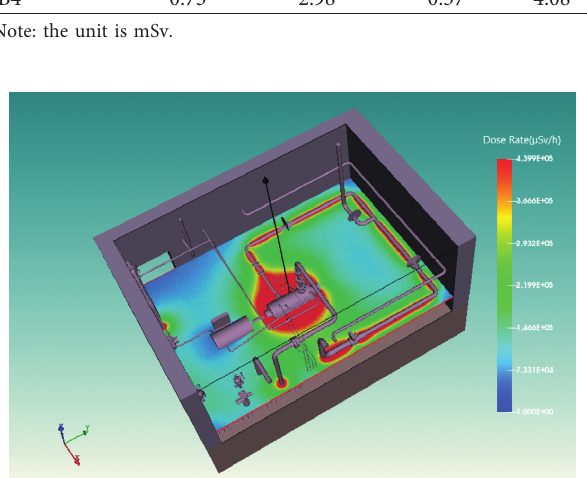
Figure 6: Example of fine 3D radiation field and display.